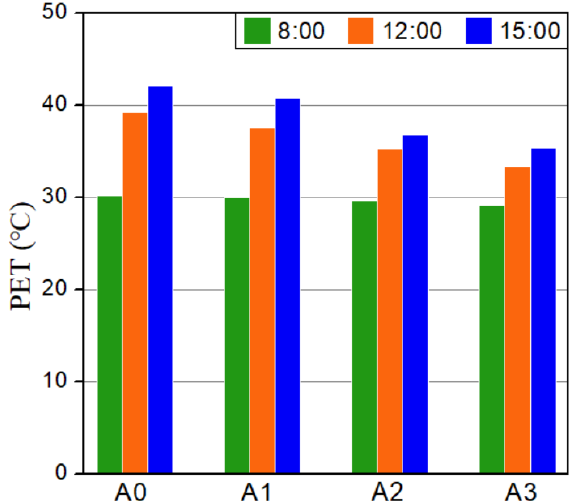
Figure 12. PET of the base case and cases with different greening rates at 8:00, 12:00, and 15:00.